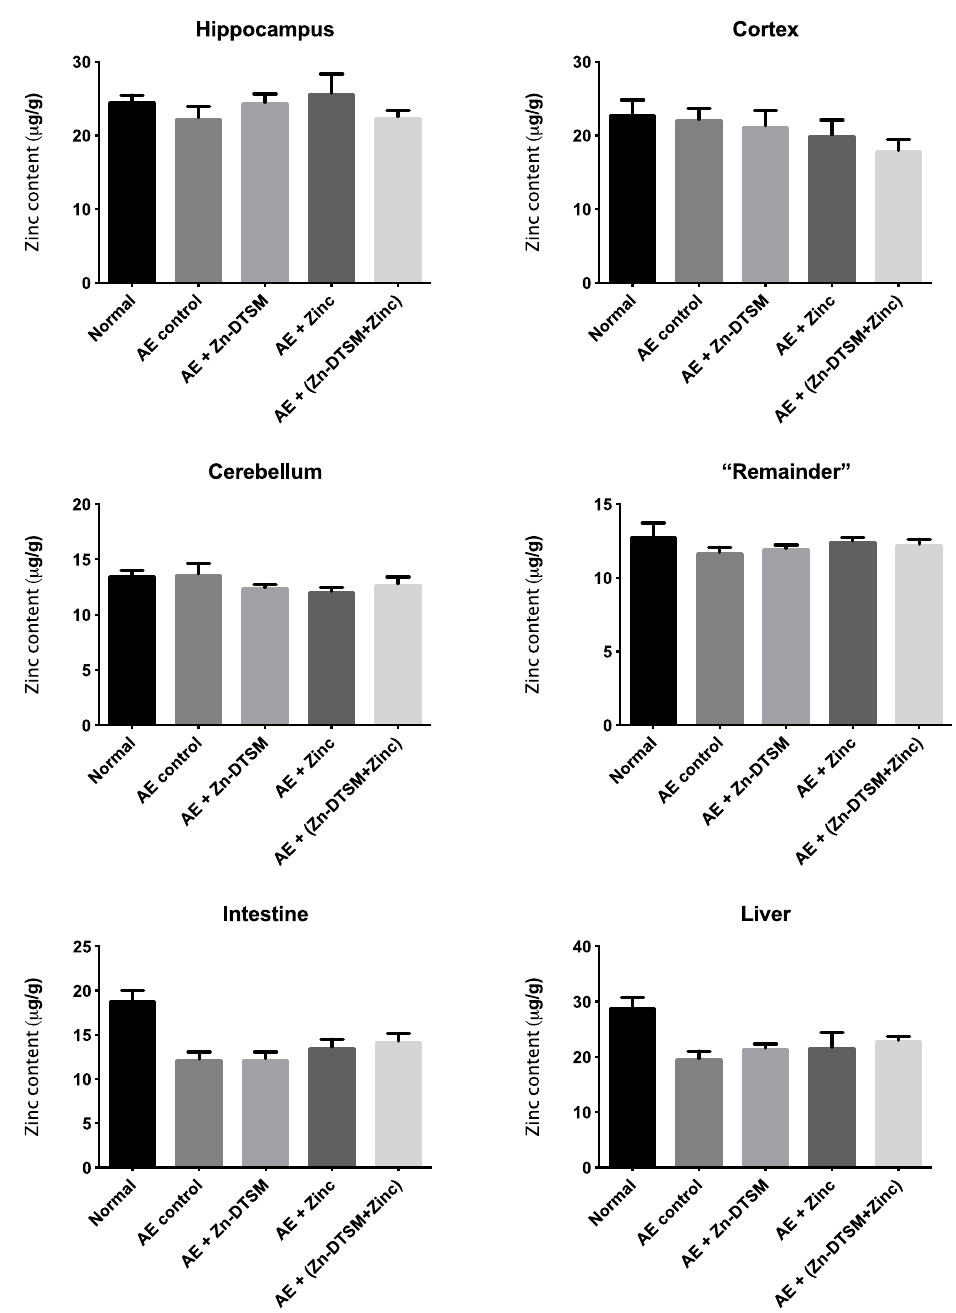
Figure 8. Zinc levels in various tissues harvested from 5-month-old acrodermatitis enteropathica (AE) mice treated with zinc diethyl bis(N4-methylthiosemicarbazone) (Zn-DTSM; 3 mg/kg/day). There are no significant effects of the drug, zinc supplementation or the combination of the drug+zinc on metal levels in any of the tissues examined. Data are mean ± SEM.